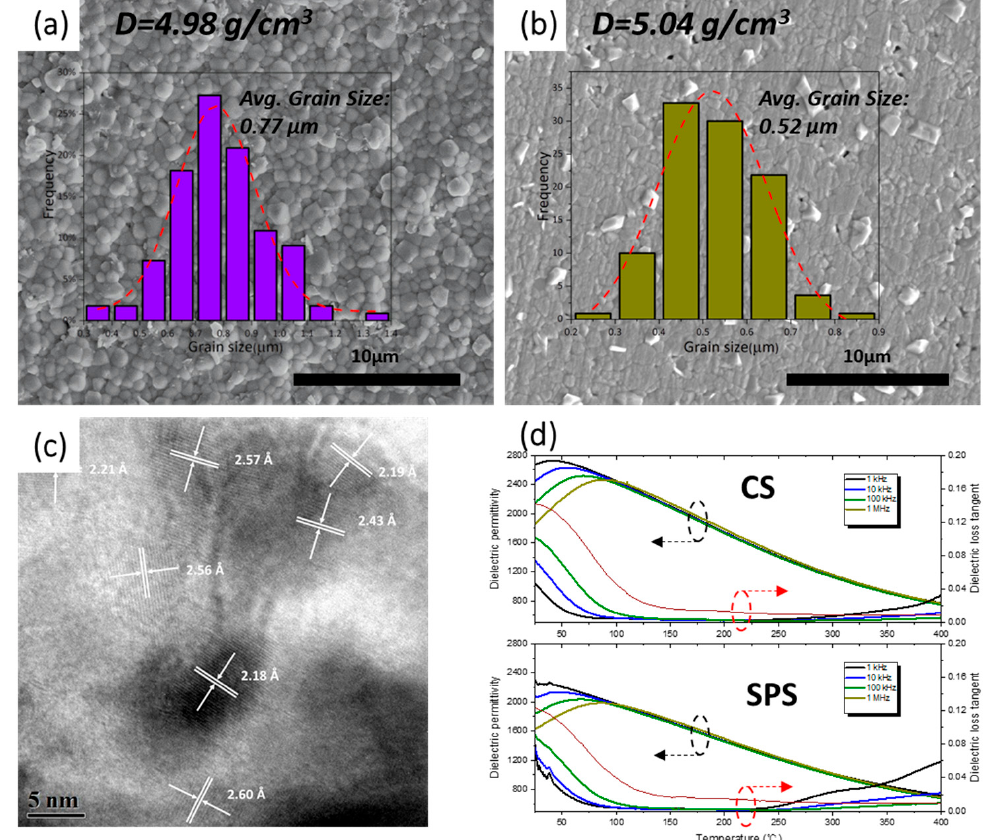
Figure 2. Microstructures of the BNSBCT ceramics prepared by different sintering methods: ( a ) con- ventional sintering, and ( b ) spark plasma sintering. ( c ) HR-TEM image and ( d ) dielectric properties of the BNSBCT ceramics prepared by CS and SPS.